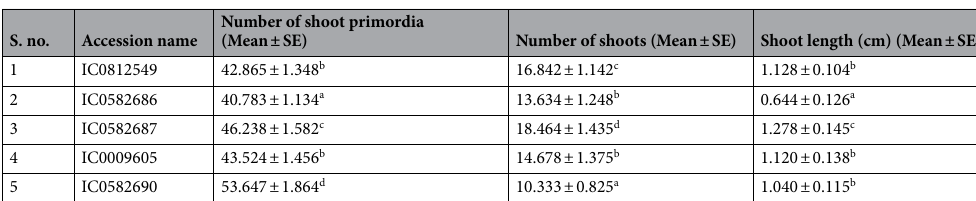
Table 2. In vitro multiplication response of five Xanthosoma accessions on optimized culture medium (MS + 0.2 mg/L BAP + 0.1 mg/L NAA ). Data represents mean ± SE of six replicates per treatment in three repeated experiments. Means within the same column followed the different letters are significantly different according to Duncan’s multiple range test (DMRT) at 5% level.